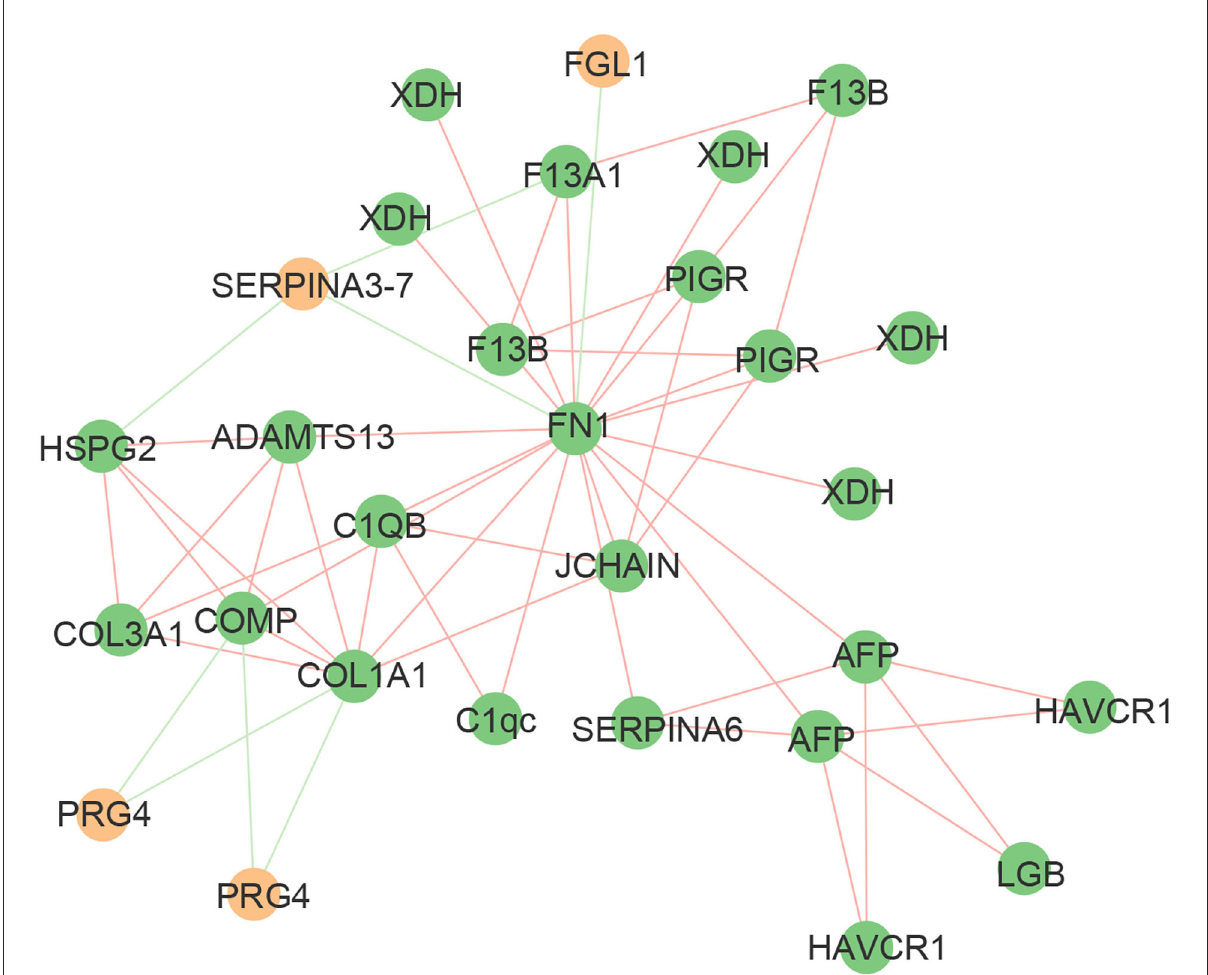
FIGURE5 Mapping of significantly differential proteins onto a composite network based on predicted PPI. The edges of the network symbolize different interactions between proteins, based on the actions view of STRING v11.0. The green edges indicate a negative correlation and the red edges indicate a positive correlation. The green nodes indicate upregulated proteins and the yellow nodes indicate downregulated